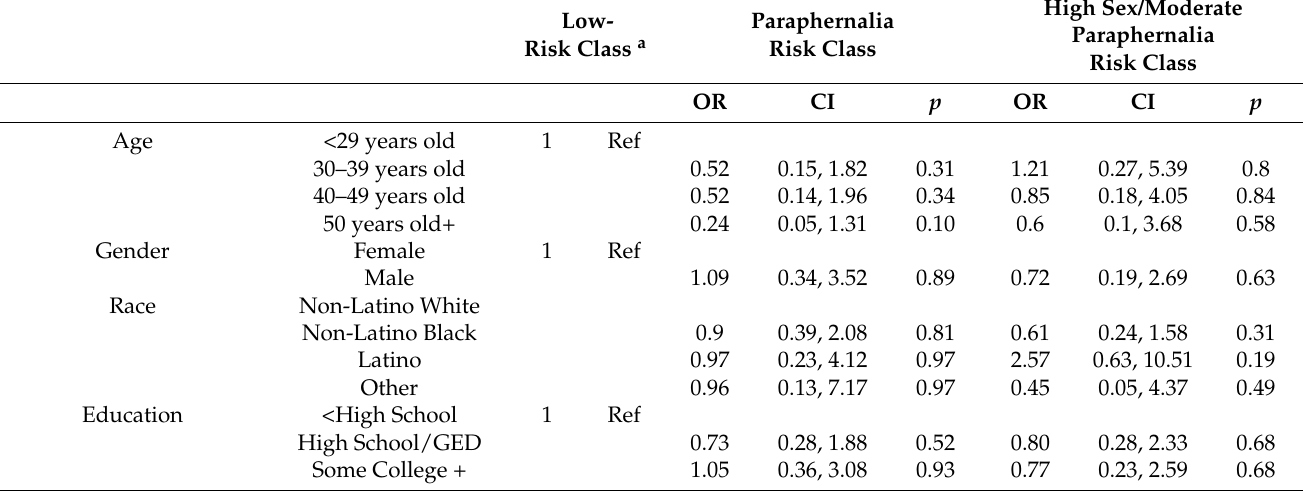
Table 5. Multinomial logistic regression analysis of selected individual and network demographic characteristics variables for latent class membership. ( n =